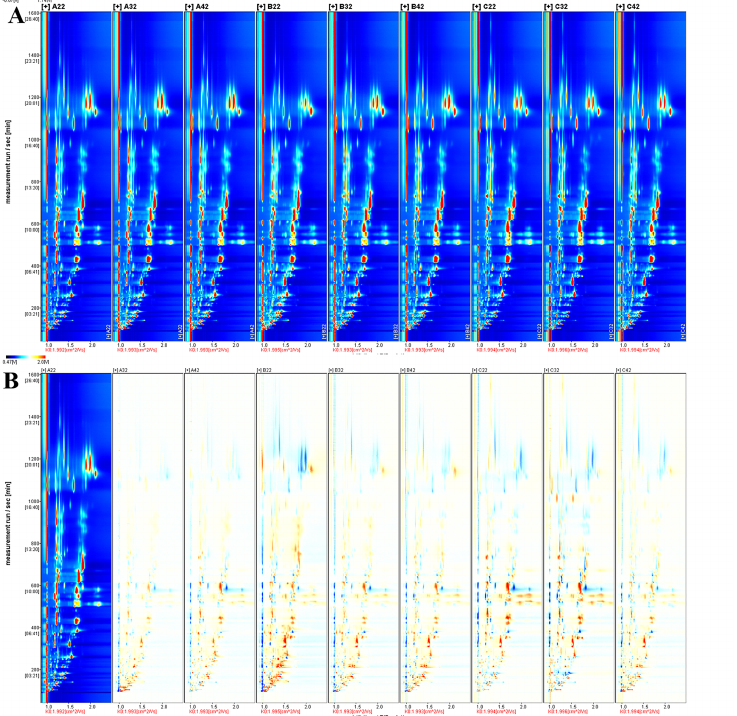
Figure 4. Topographic plots of the compounds isolated from AEOs from different regions using gas chromatography–ion mobility spectrometry (GC-IMS): A (Wenshan), B (Nujiang), C (Tengchong). ( A ) depicts the total volatile organic compounds (VOCs), and each colored point represents a compound. Red represents high concentration, and dark blue represents almost not present. Increasing color darkness from dark blue to red depicts increasing concentration. In ( B ), for VOCs of analytes with the same concentration compared to the reference (A1), the color would be white. Red and blue indicated that the concentration of VOC is more and less than the reference,